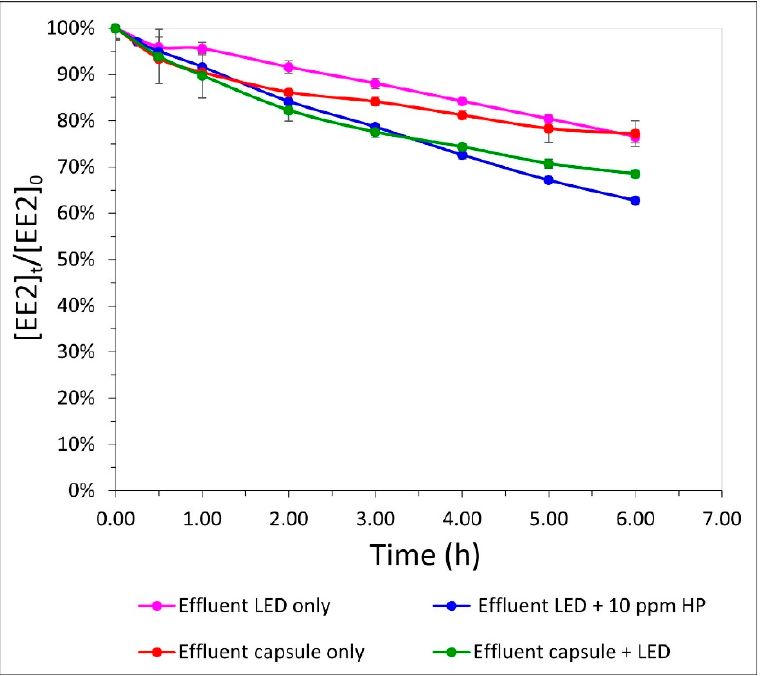
Figure 4. Comparison of EE2 hormone (0.5 mg/L) degradation in 3 L of effluent wastewater, using different processes: UV-LED at wavelengths 267.7 nm and 277.4 nm, SBP, UV-LEDs with SBP, and UV-LEDs with 10 mg/L H 2 O 2 (HP) versus time.